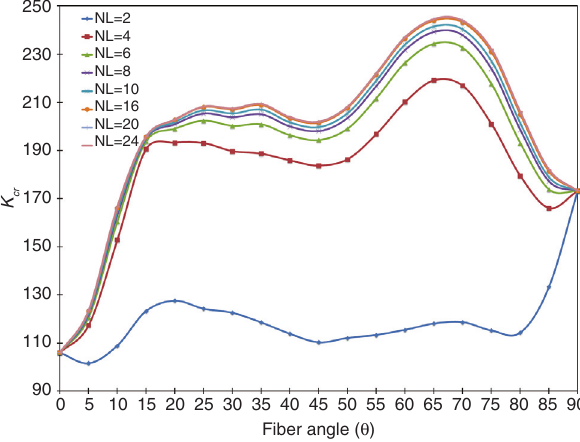
Figure 16 Critical buckling load parameter for clamped antisym- metric cylindrical skew panel (Ø = 30 ° , α = 15 ° ).